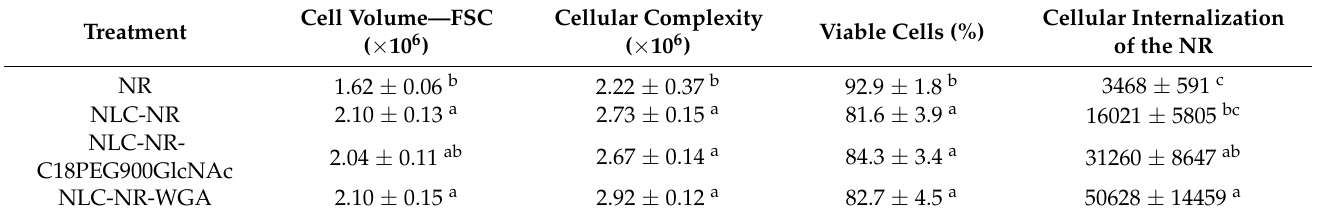
fluorescence intensity of the NR was analyzed. At the highest concentration tested (2750 µ g/mL), the cells incubated with NLC-NR-WGA presented a higher fluorescence intensity of NR when compared to NLC-NR, indicating that WGA functionalization was more efficiently incorporated by cells. However, no differences were found in the NLC-NR-C18PEG900GlcNAc. Moreover, an increase in cellular volume and complexity was observed for cells exposed to all NLCs. A decrease in viable cells was observed when cells were exposed to different NLCs when compared to NR control (Table 4). Table 4. Results of fluorescence intensity inside cells after 24 h of exposure to the proposed treatments. The data were expressed as mean ± standard deviation. Different letters on the same column indicate significant differences based on the Kruskal–Wallis non-parametric test with a significance limit of 0.01. Treatment